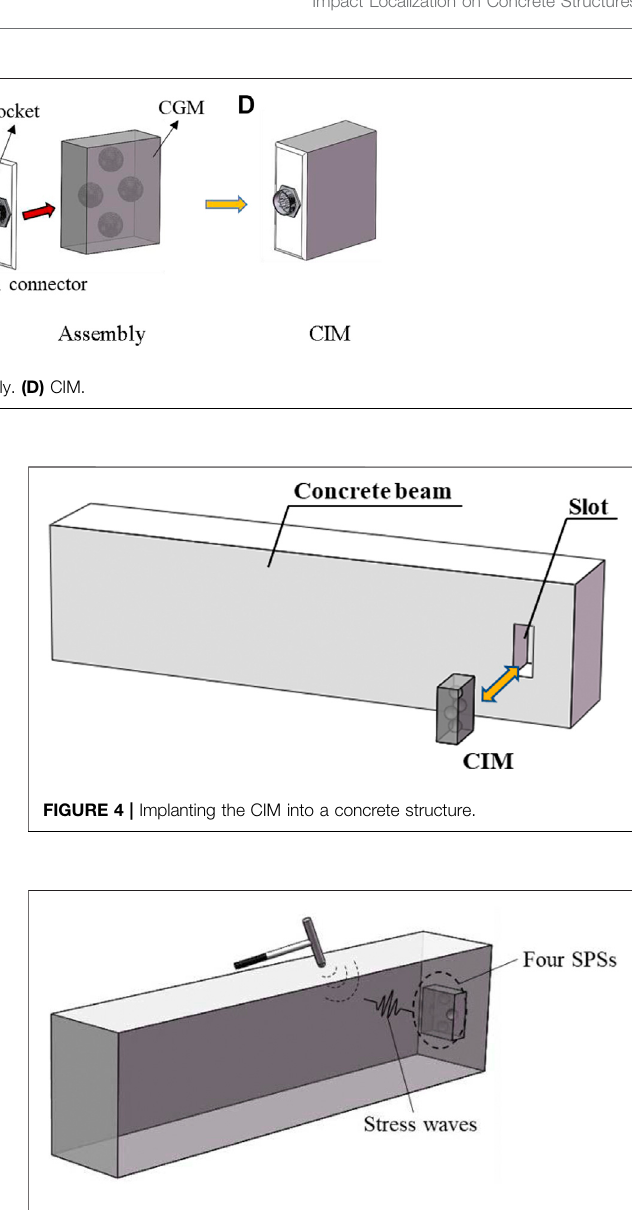
FIGURE 5 | Detection of the impact